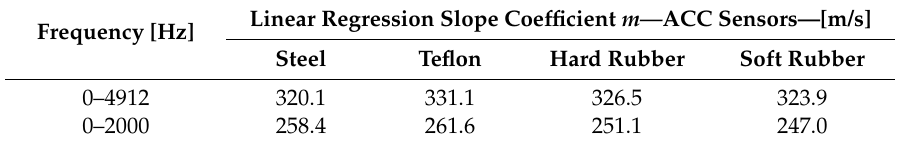
Figure 13. ( Δ L – Δ T ) visual approach results for the ACC sensors, sandwich panel, all tips, filtered with the 0–8000 Hz